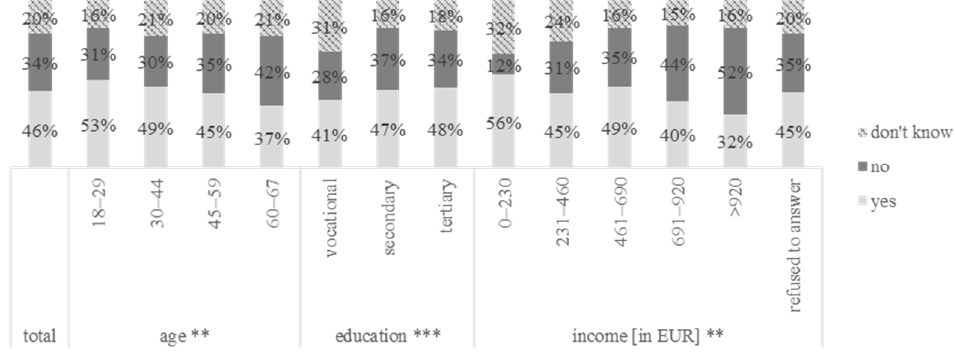
Figure 1. Preference for replacing compulsory contributions with higher net remuneration. Source: authors’ own elaboration, *** p < 0.01, ** p < 0.05, * p < 0.1.